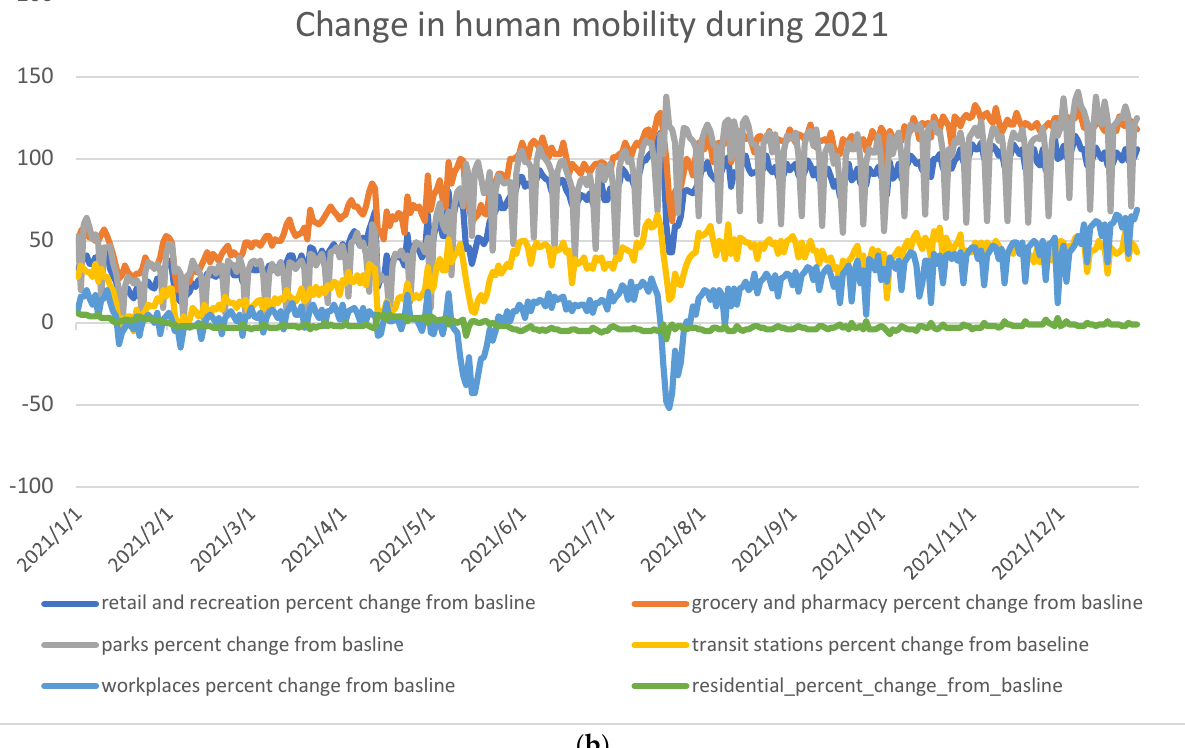
Figure 2. ( a ) Human mobility after the start of containment measures in Yemen during 2020. Blue = Retail and recreation, Red = Grocery and pharmacy, Gray = Parks, Orange = Transit stations, Light blue = Workplaces, Green = Residential; ( b ) Human mobility after the start of containment measures in Yemen during 2021. Blue = Retail and recreation, Red = Grocery and pharmacy, Gray = Parks, Orange = Transit stations, Light blue = Workplaces, and Green = Residential.